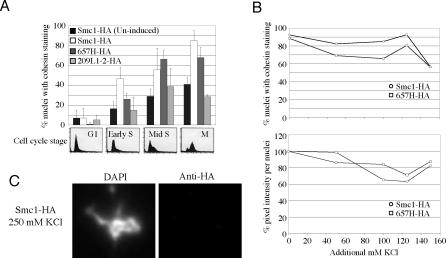
Binding of Cohesins to Chromosomes in S Phase Is Not Sufficient to Establish Cohesion(A) MM10 cells containing minichromosomes with different Smc1 alleles were released from G1 in media that supported either induced or uninduced expression of the mutant Smc1 alleles, inactivated smc1–2, and prevented progression beyond metaphase (see Materials and Methods). Aliquots of cells were removed at specific time intervals after release from G1. These aliquots were processed for flow cytometry to determine DNA content and used to prepare spread nuclei to follow chromosome staining of the different Smc1 proteins. The percent of nuclei with chromosomal staining was determined as well as the average pixel intensity per nuclei (unpublished data).(B) To assess the stability of this chromosome-associated cohesin, mitotic-arrested nuclei were spread on slides in the absence of fixative and incubated in buffer containing different amounts of additional KCl. The percent of nuclei with chromosomal staining and the average pixel intensity per nuclei were determined. The average pixel intensity is expressed as a percentage of the intensity in the absence of additional salt.(C) A micrograph of a representative nucleus (DAPI) and the chromosome staining of the Smc1-HA (anti-HA) after treatment with 250 mM KCl.